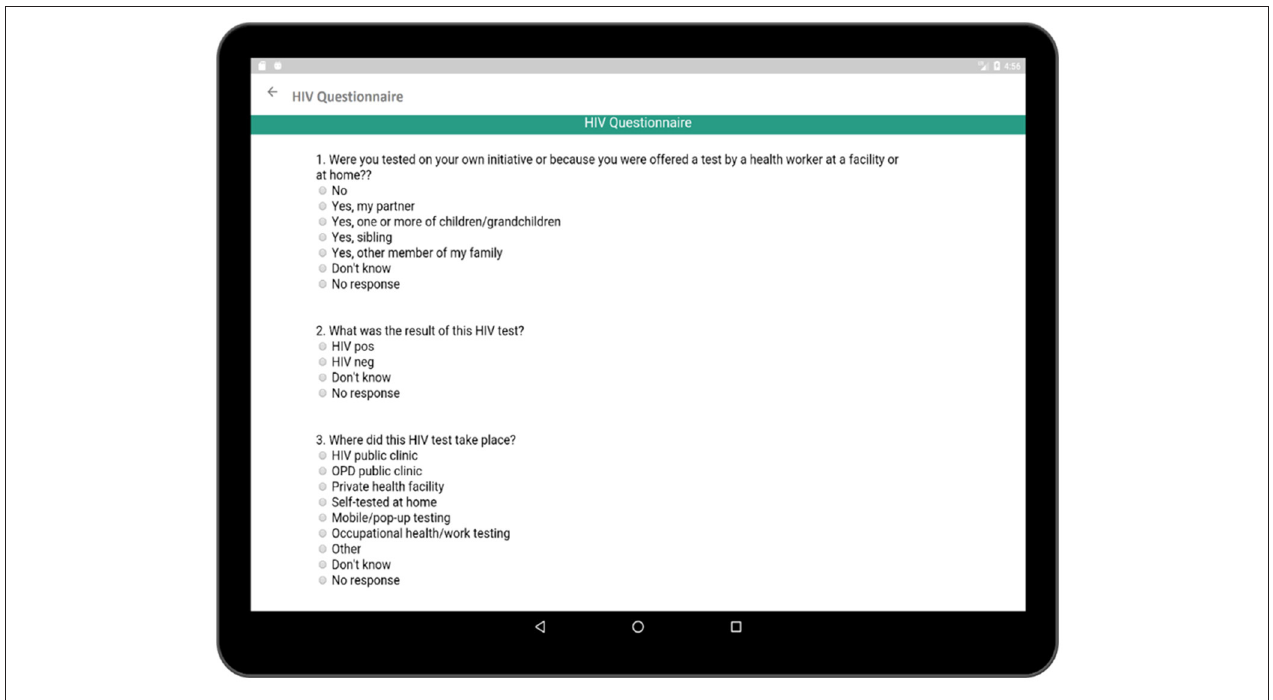
FIGURE 11 | Questionnaire related to recording longitudinal pattern of HIV testing behavior.